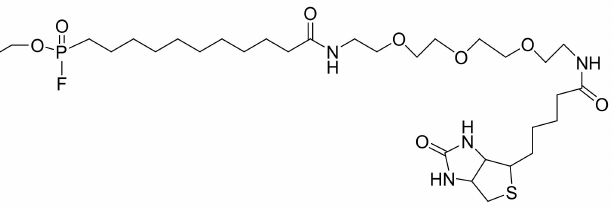
Figure 5. Chemical structure of B24P. The compound was synthesized with a series of reactions starting from the MA reaction between the 11-undecanoic acid and triethyl